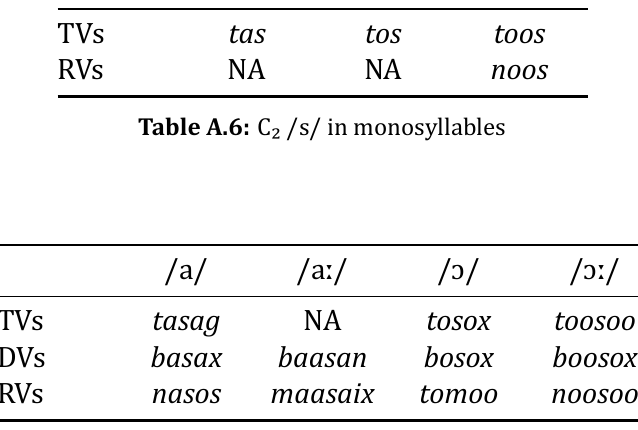
Table A.7: C₁ /s/ in